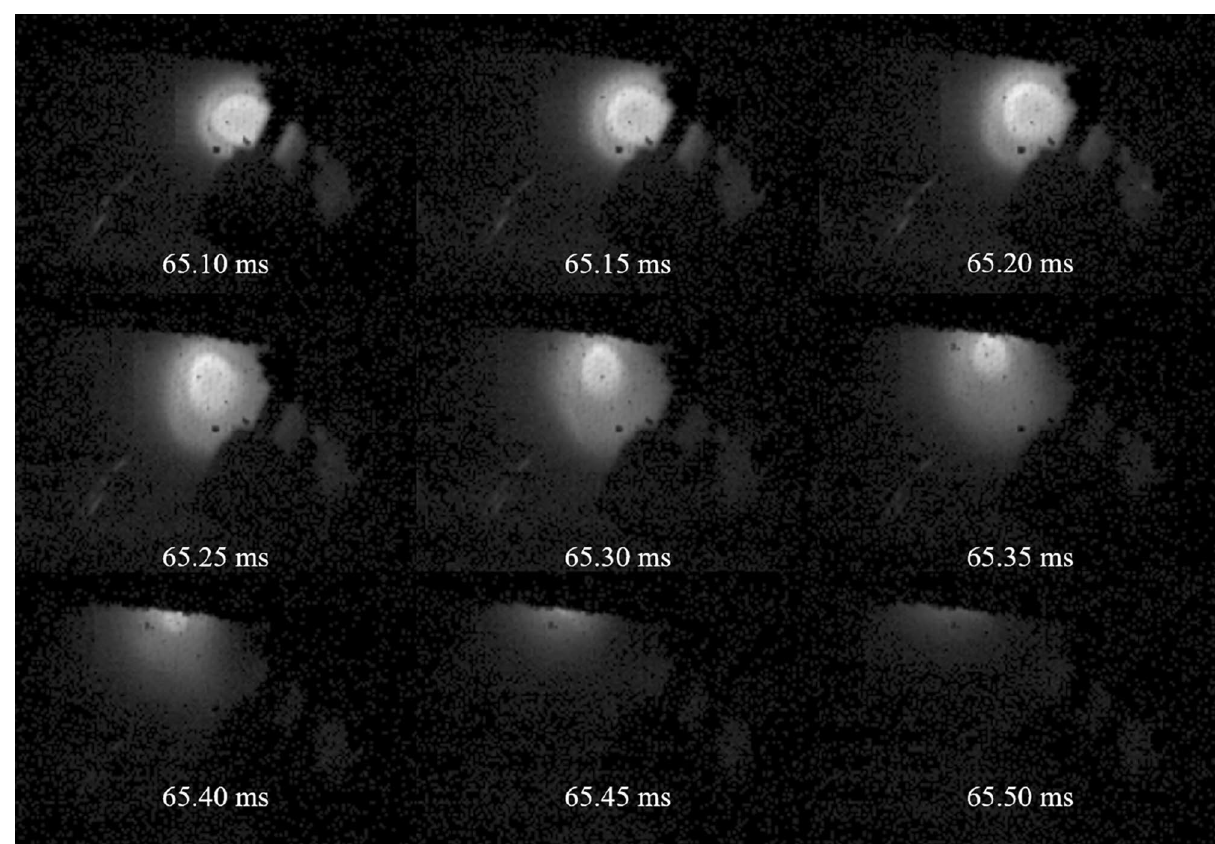
Figure 2. Sequential images of pellet injection in shot#79188. See supplementary video